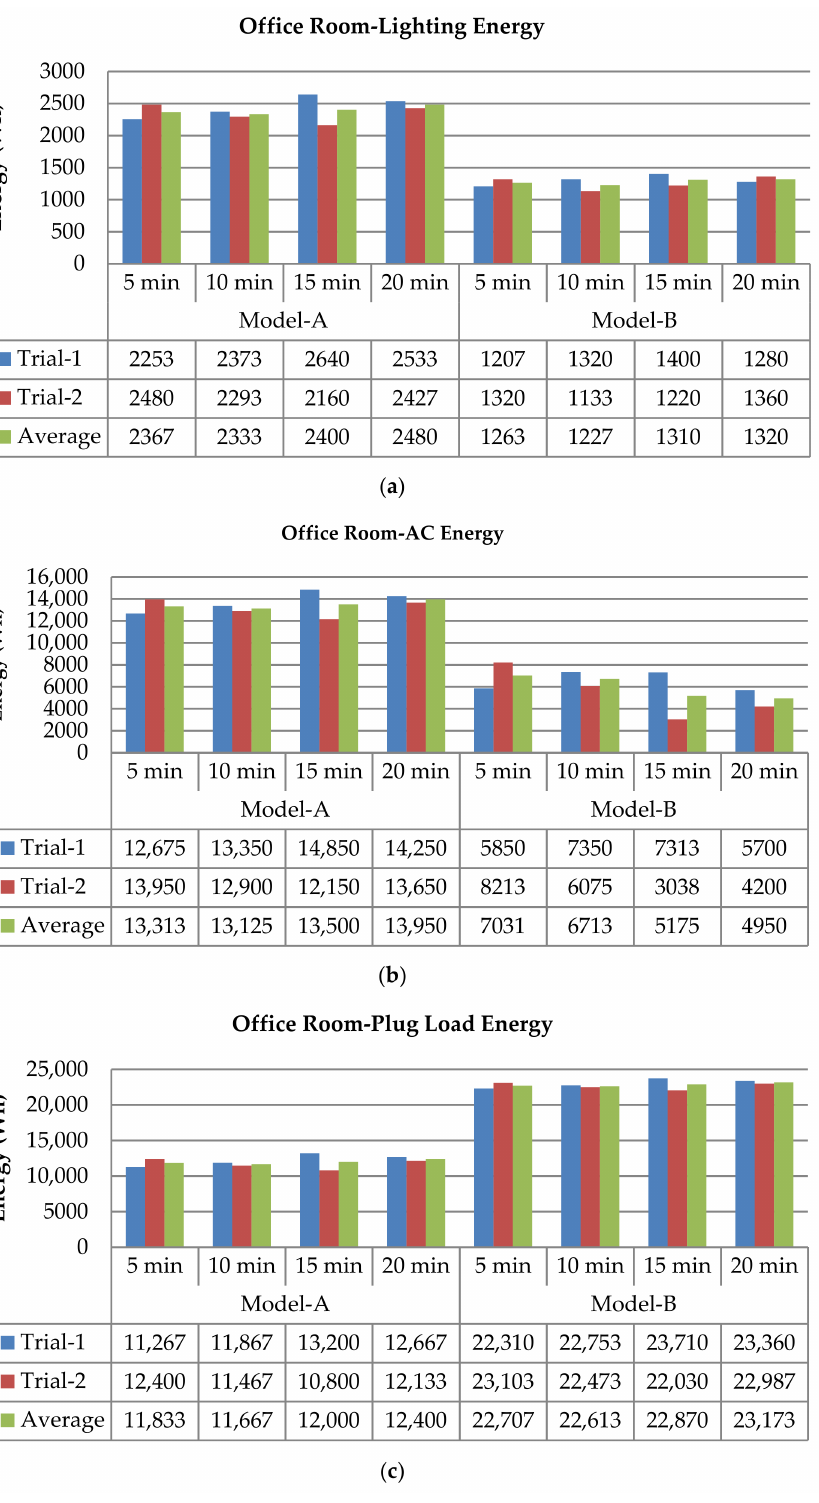
Figure 11. Energy consumption in the Office room: ( a ) lighting energy; ( b ) AC energy; ( c ) plug load